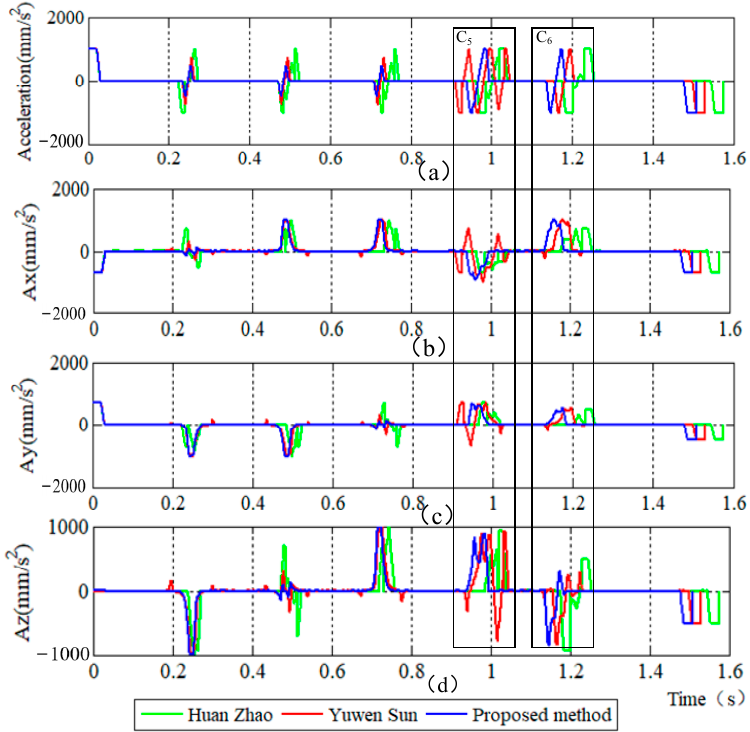
Figure 11. Acceleration profiles of 3D tool path.